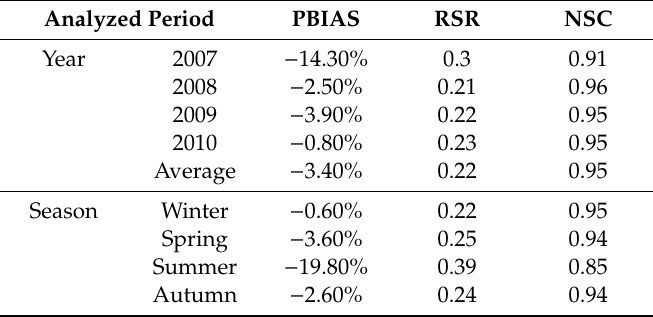
Table 4. Annual and seasonal results for the statistical indices (percentage bias (PBIAS), ratio of the root mean square error to observation standard deviation (RSR), Nash–Sutcli ff e coe ffi cient (NSC)) applied for the validation of simulated total flow.